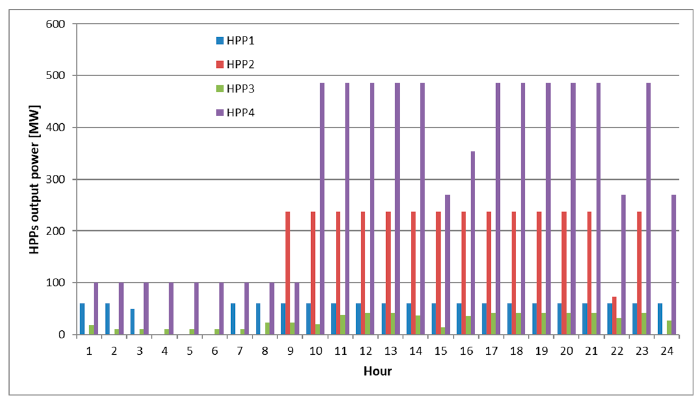
Figure 10. Optimal day-ahead dispatch plan of the HPPs obtained by the first optimization stage.